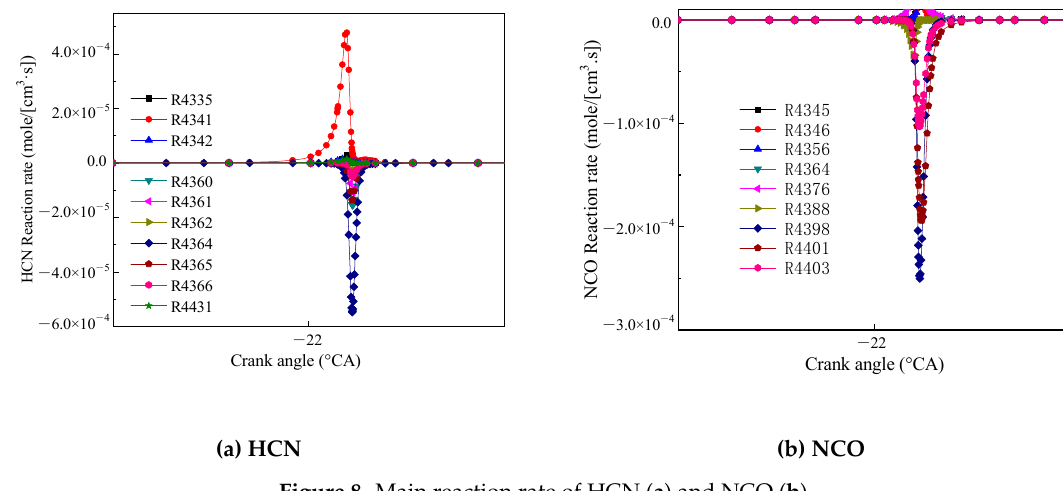
Figure 8. Main reaction rate of HCN ( a ) and NCO ( b ).